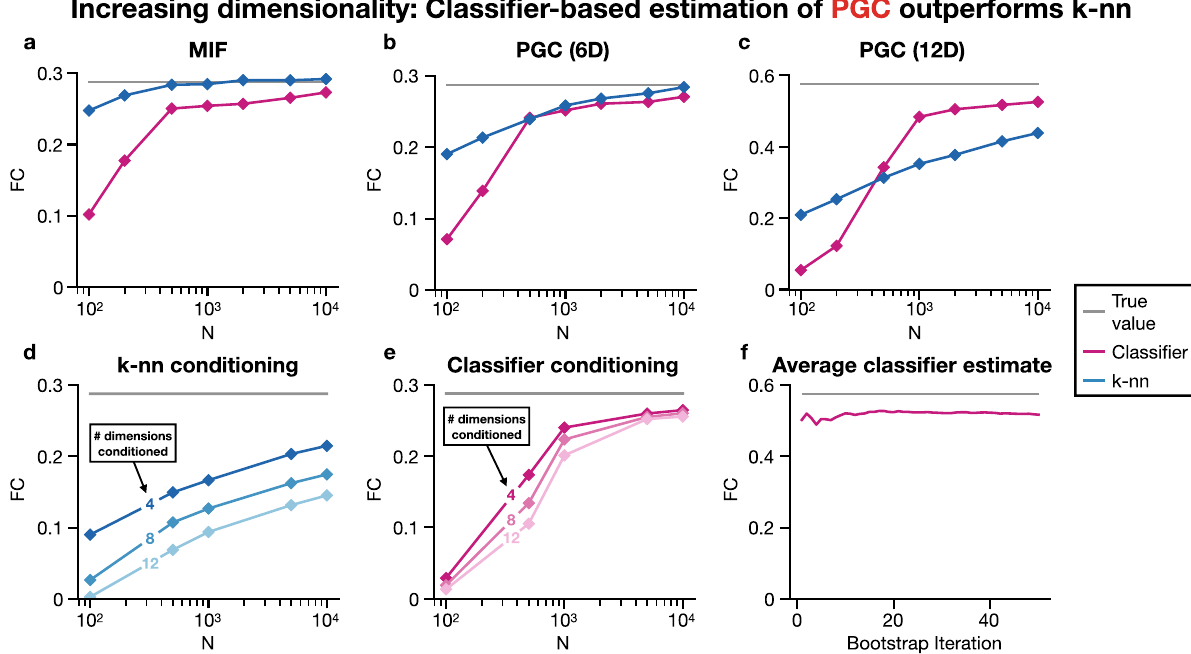
Figure 5. Estimating MIF and PGC between Gaussian spectral increments via k -nn and classifier. All plots except (f) include variance errorbars (too small to visually observe). ( a ) k -nn outperforms classifier for MIF, particularly for low samples. ( b ) k -nn has narrower advantage over classifier when estimating PGC between two spectral increments conditioned on a third increment (six-dimensional problem). ( c ) Classifier outperforms k - nn at N = 500 samples and greater for larger twelve-dimensional problem where PGC is estimated between two pairs of spectral increments conditioned on a third pair of spectral increments. ( d ) Effect of conditioning k -nn- based PGC between two spectral increments on two pairs of spectral increments (four dimensions), four pairs of spectral increments (eight dimensions), and six pairs of spectral increments (twelve dimensions). ( e ) Analysis of classifier in same manner. Notably, with increasing sample size classifier significantly outperforms k -nn. ( f ) Using multiple bootstrap iterations for classifier-based estimation of PGC reduces estimate variability as shown by the cumulative average PGC estimate over bootstrap